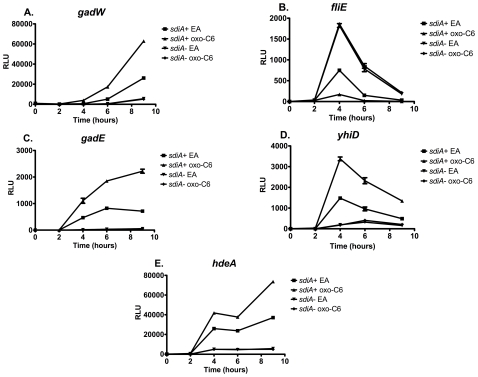
Regulation of AHL-regulated genes of E. coli K-12 and EHEC in motility agar containing either 100 nM oxo-C6 or the solvent control, EA at 37°C.Luminescence in relative light units (RLU) was measured using a Wallac Victor2 1420 multimode plate reader at the time intervals noted. Each strain was assayed in triplicate and error bars represent standard deviation. A) AL4001/JLD800 (gadW), B) JLD604/JLD803 (fliE), C) JLD605/JLD804 (gadE), D) JLD607/JLD806 (yhiD), E) JLD610/JLD809 (hdeA).